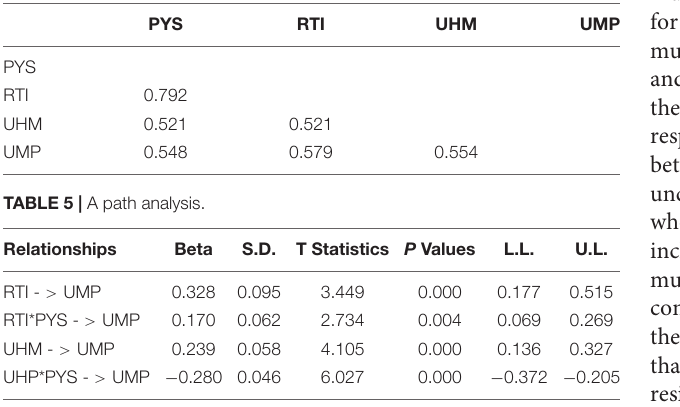
TABLE 4 | Heterotrait Monotrait ratio.